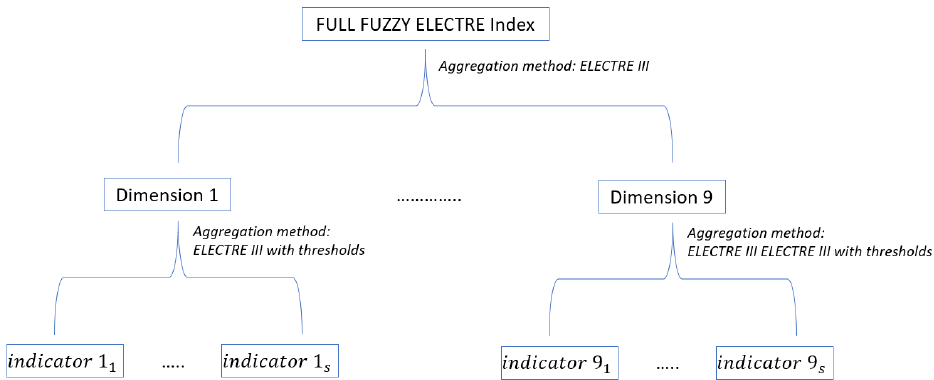
Figure 3. The second variation that we propose: FULL ELECTRE Index.